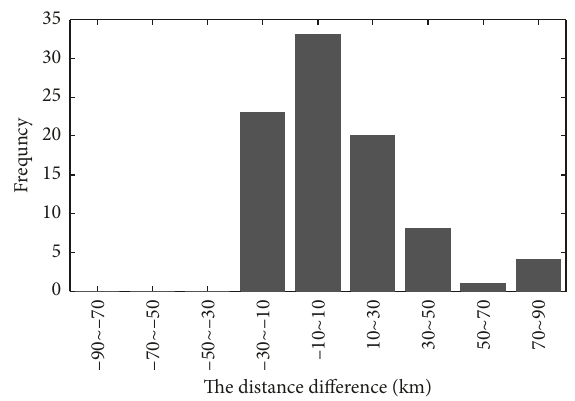
Figure5:Thehistogramofthedistancedifference(DD)betweenthe TC centers obtained from SLP with Barnes filter or without Barnes filter and that from best-track